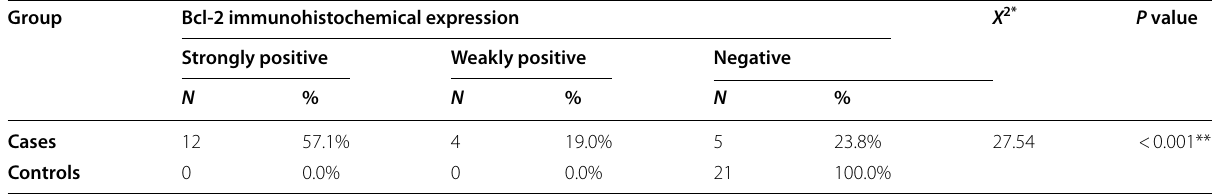
* Fisher’s exact test ** P values < 0.05 were considered statistically significant